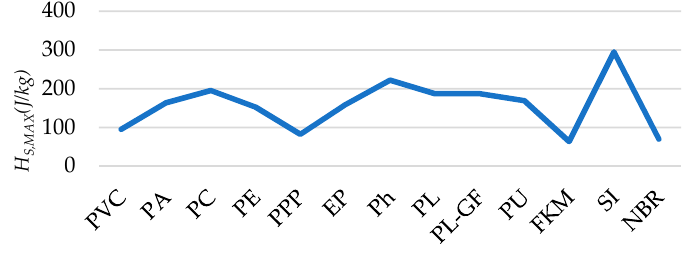
Figure 7. Maximum allowable supplied heat ( H S,MAX ).